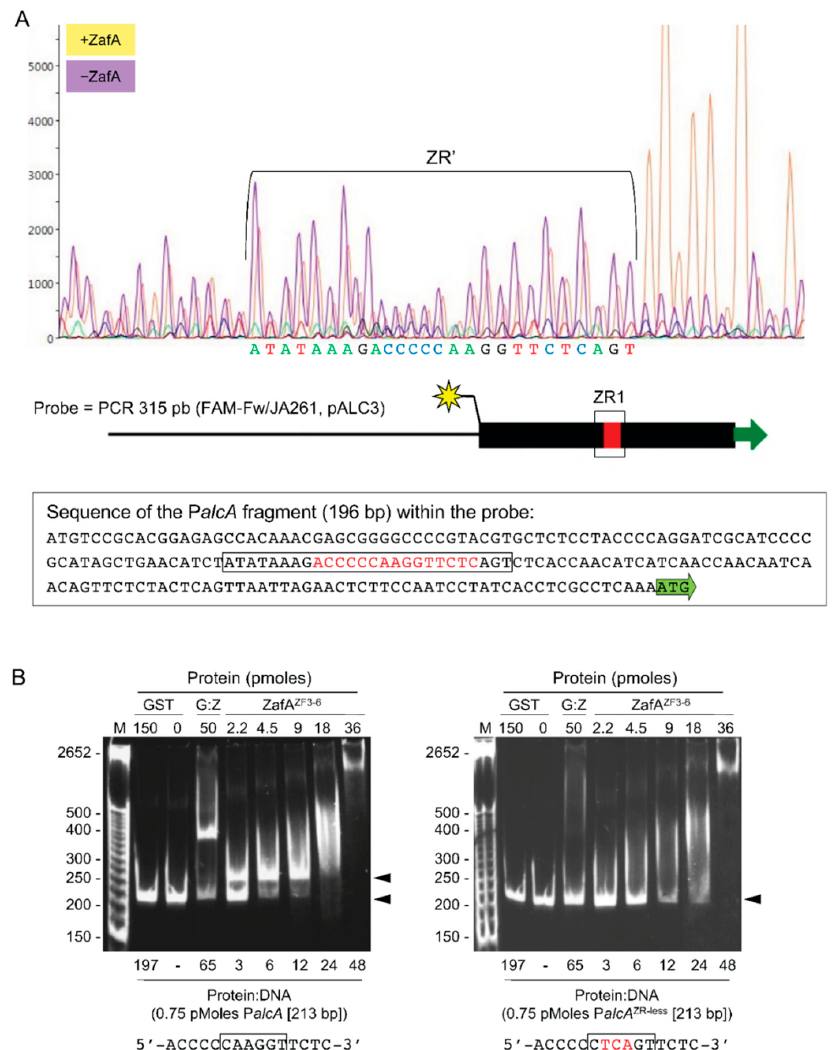
Figure 6. Effect of mutations in the conserved hexanucleotide core of the ZR consensus motif on ZafA binding in vitro. ( A ) Binding of ZafA ZF3-6 to a DNA fragment carrying a single ZR consensus motif in a CT-rich context as shown by a DNase I protection assay. The purple chromatogram was obtained upon incubating the DNA fragment in the absence of ZafA ZF3-6 , such that the DNA remained naked and, hence, unprotected from DNase I digestion. The yellow chromatogram was obtained upon incubating the DNA in the presence of ZafA ZF3-6 . ZafA bound to DNA prevented its digestion with DNase I resulting in a stretch of yellow peaks lower in high than purple peaks. A short stretch of high yellow peaks at the right side of the chromatogram indicated a hypersensitive region to DNase I digestion. The protected region is delimited by a bracket. Below the chromatogram is shown a schematic representation of the whole intergenic region of the alcA gene with the beginning of the ORF located at the right side (green arrow). The sequence of the DNA fragment corresponding to the P alcA used in the assay is located in the scheme as a black rectangle with the ZR consensus motif in red. The protected region has been squared in the scheme and sequence. The yellow star indicates the end 6-FAM labeled strand detected by the capillary-based automated DNA sequencer; ( B ) Analysis by EMSA of binding of ZafA ZF3-6 to a DNA fragment in which the 5 ′ -CAAGGT-3 ′ hexanucleotide core of its only ZR motif (left panel) had been mutated to 5 ′ -CTCAGT-3 ′ (right panel). The DNA fragments were also incubated without protein and in the presence of both 150 pmoles of purified GST and 50 pmoles of the fusion protein GST-ZafA ZF3-6 (as controls) to attain a GST:DNA ratio of 197 and a GST-ZafA ZF3-6 :DNA (G:Z) ratio 65. A 25-bp DNA ladder was used as a reference.